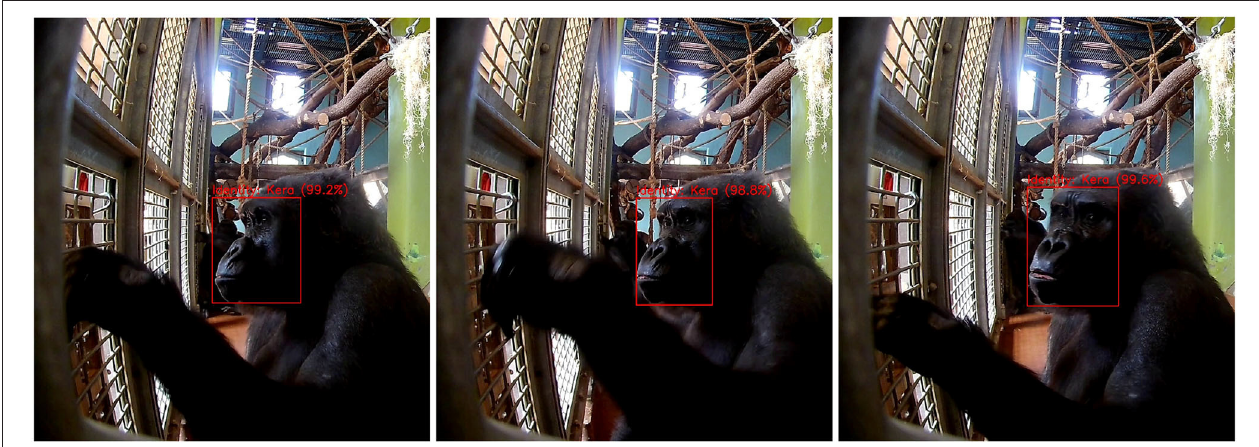
FIGURE 6 | Tracklets and voting strategies. The figure shows a sequence of three frames (at time steps t 1 , t 2 and t 3 ) of a gorilla engaging with the Gorilla Game Lab device. The red boxes represent model predictions with the identity and confidence shown above the box, as in this figure. In this sequence of frames the true identity of the gorilla is Kera. The maximum voting strategy uses only the highest detection confidence (99.6%) at t 3 to assign an identity across all time steps. The average voting strategy uses the highest average probability for each detected gorilla identity, where the mean is always calculated using the total number of time steps.